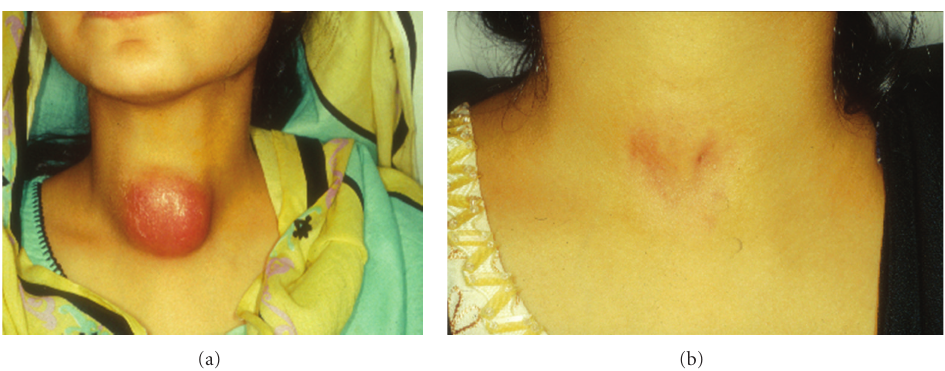
Figure 1: (a) Large nodule in front of the neck (before Treatment). (b) Complete resolution of swelling after treatment.